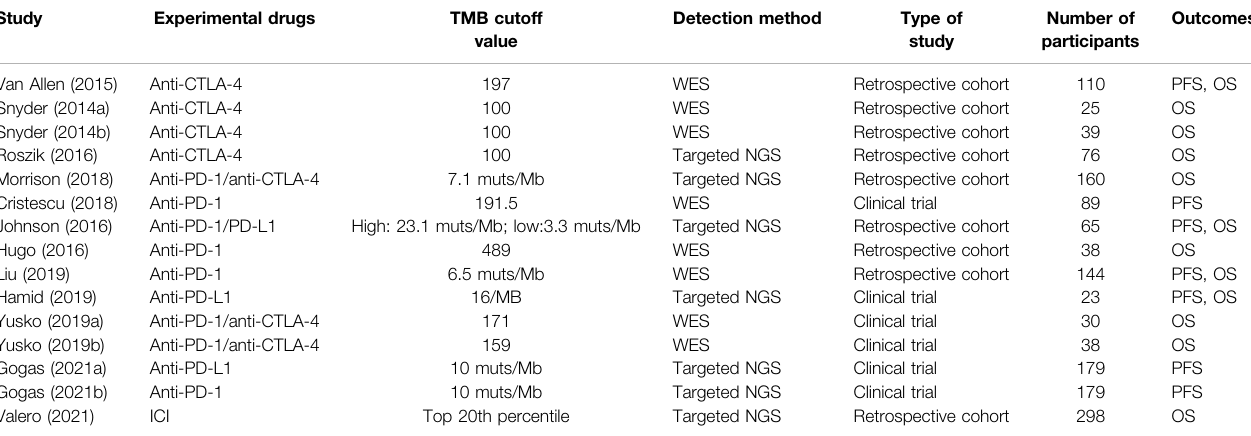
TABLE 1 | Basic characteristics of included studies.